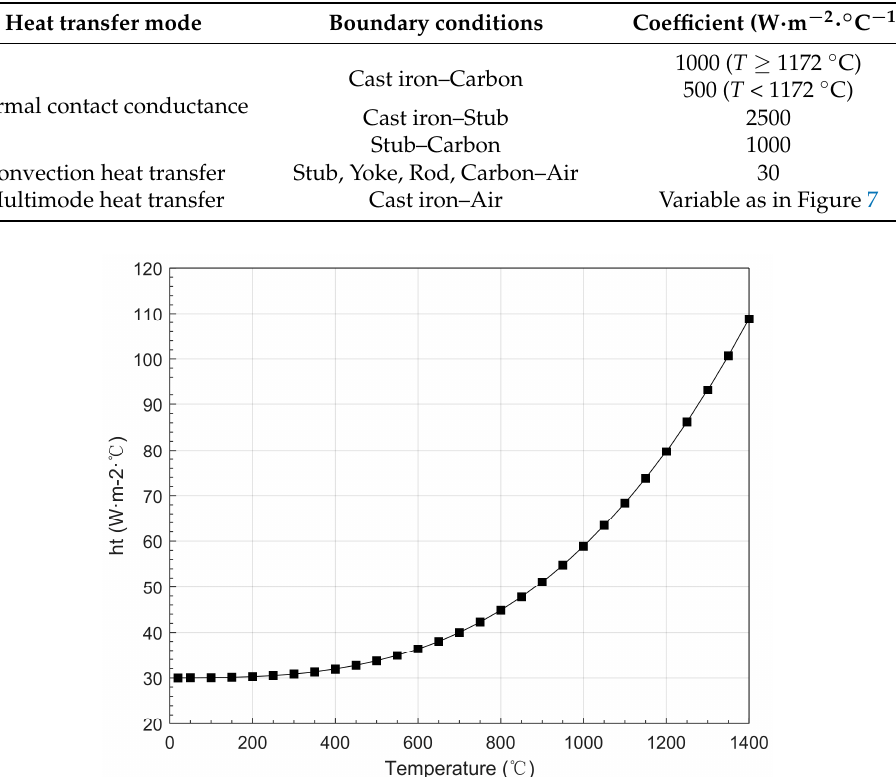
Figure 7. The multimode heat transfer coefficient over temperature.